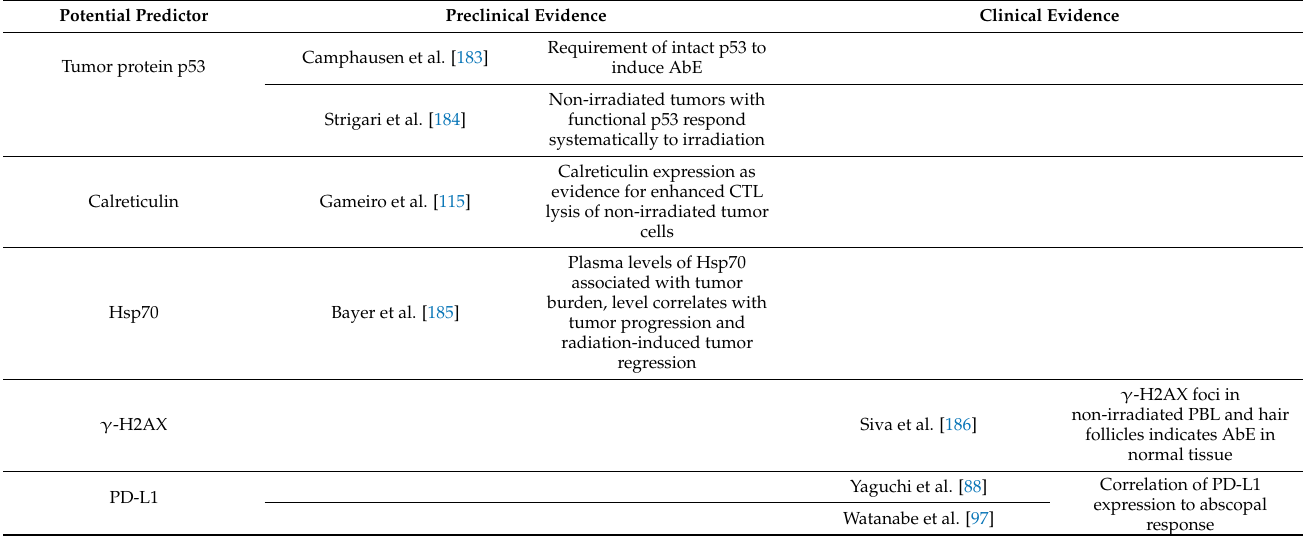
Table 4. Potential predictive biomarkers for abscopal